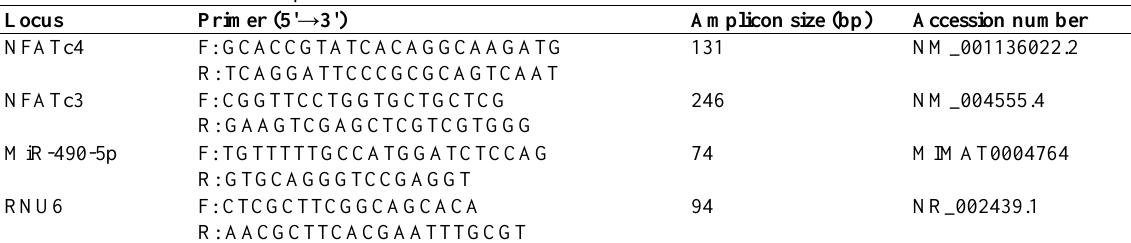
Table 1. Primers used in